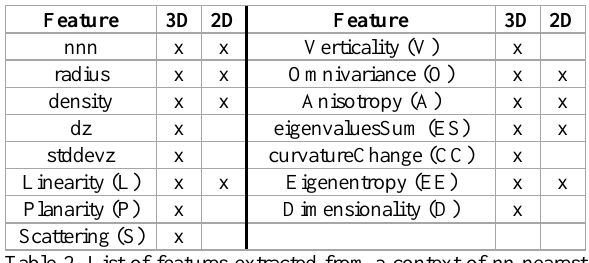
Table 2. List of features extracted from a context of nn